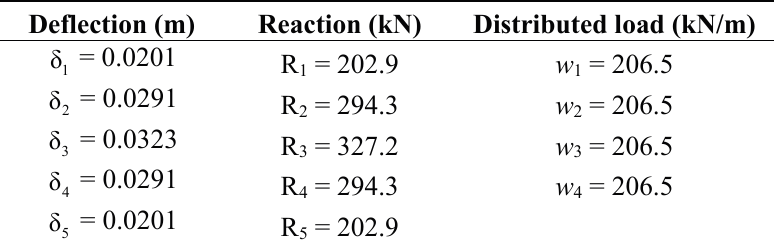
Table 1. Estimated values for deflections, reactions, and distributed loads for the 4-span beam. Deflection (m)